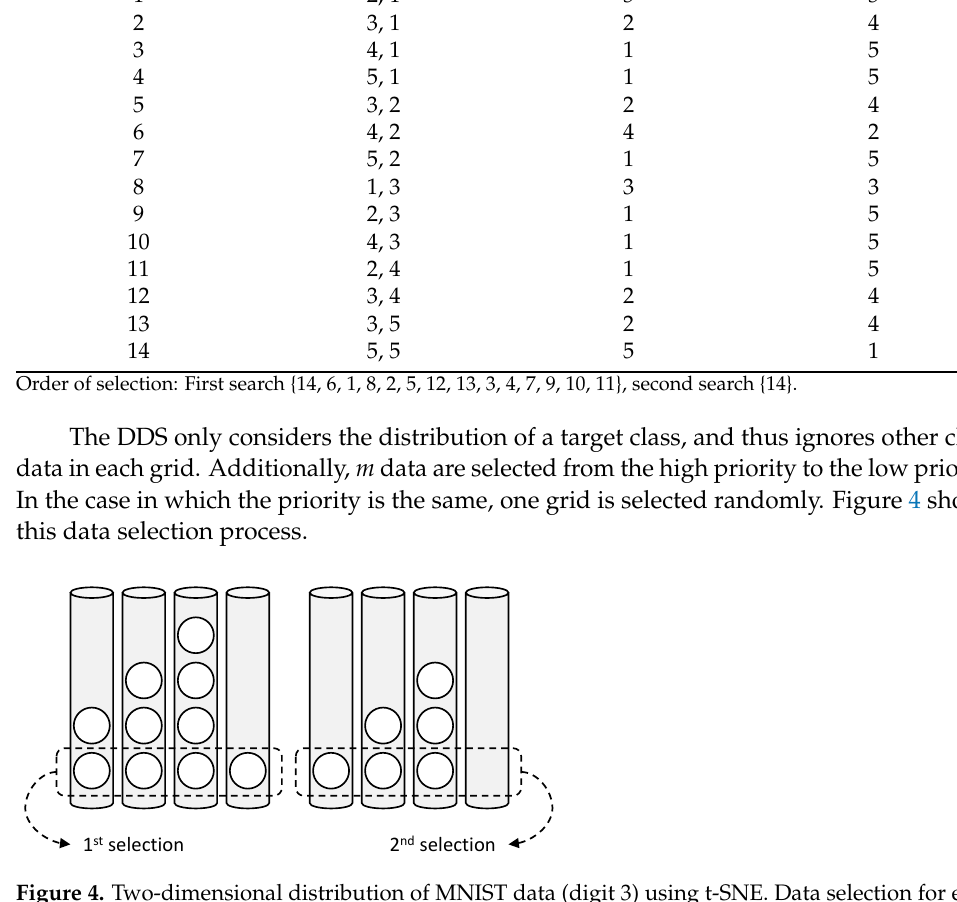
Figure 4. Two-dimensional distribution of MNIST data (digit 3) using t-SNE. Data selection for each step based on the DDS (select m data from each grid sequentially, currently m is 1). There are 2, 3, 4, and 1 target data in four grids (cylinders in the figure) in the left of Figure 4. Because m is equal to one, one datum is selected from all grids in the first search and the fourth grid becomes empty. Thus, in the second search, one datum is selected from the three grids. This process is run continually until n data are selected in total.